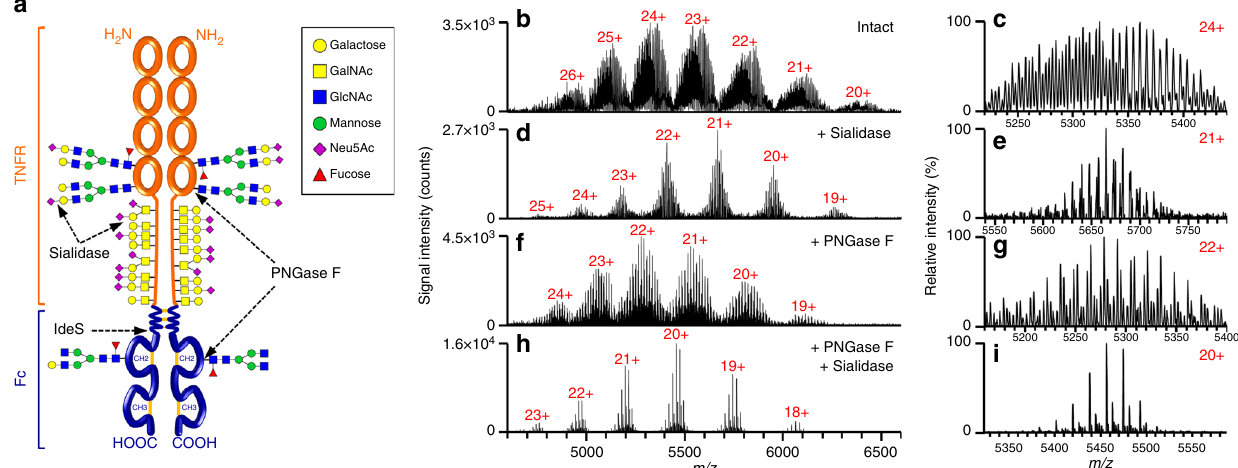
Fig. 1 Molecular structure and native mass spectrometry of Etanercept. a Schematic illustration of dimeric Etanercept consisting of a TNFR and an Fc domain. Disul fi de bonds in the Fc region are indicated as yellow lines; disul fi de bridges in the TNFR domain are not shown. Monosaccharide symbols are listed. Exemplary cleavage sites of IdeS, PNGase F and sialidase are indicated. Native mass spectra of b intact Etanercept ( R set = 17,500 at m/z 200), d Etanercept digested with sialidase or f PNGase F ( R set = 35,000 at m/ z 200), and h a combination of PNGase F/sialidase, respectively ( R set = 70,000 at m/z 200). Charge states are indicated. Zooms into the most abundant charge states are shown in c , e , g , and